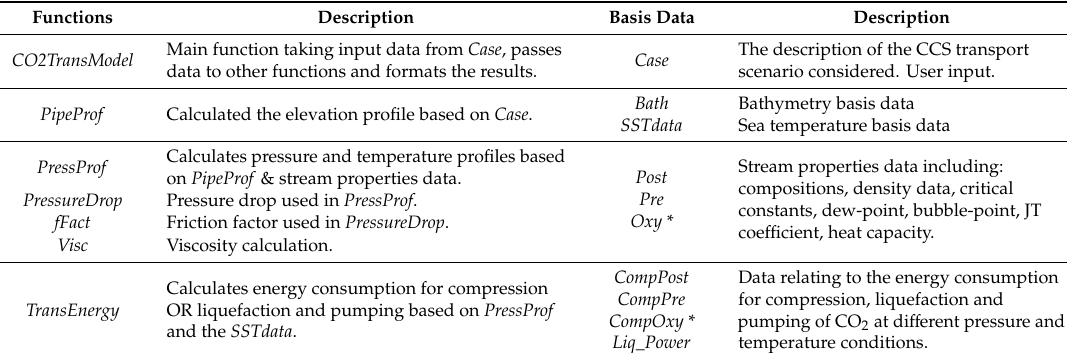
Table 1. Summary of Functions and Basis